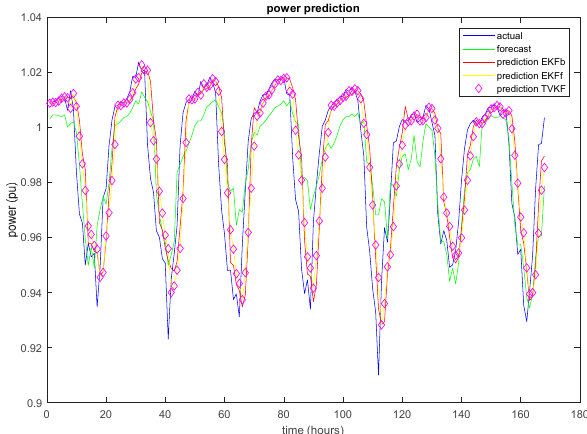
Figure 5. The Extended Kalman Filter is equivalent to two Time Varying Kalman Filters combined.